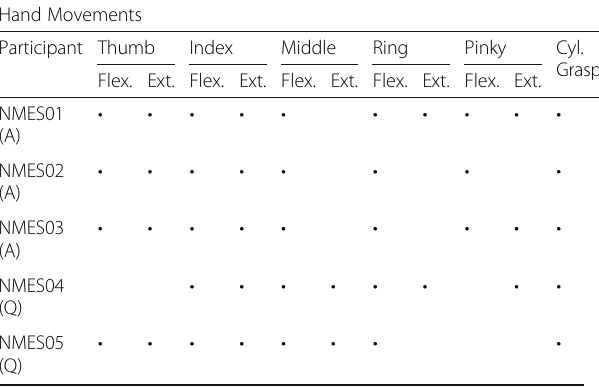
Table 1 Hand movements visually observed in able-body (A) and participants with quadriplegia (Q) Hand Movements Participant Thumb Index